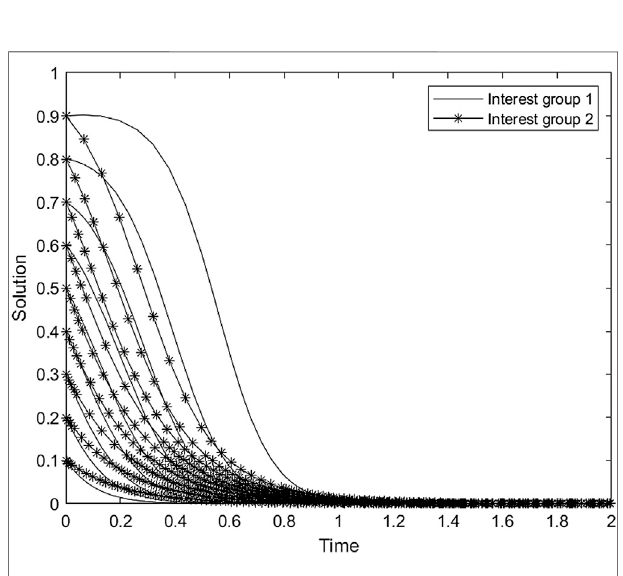
FIGURE 7 | Simulation result of the point E 1 ( 0 , 0 )